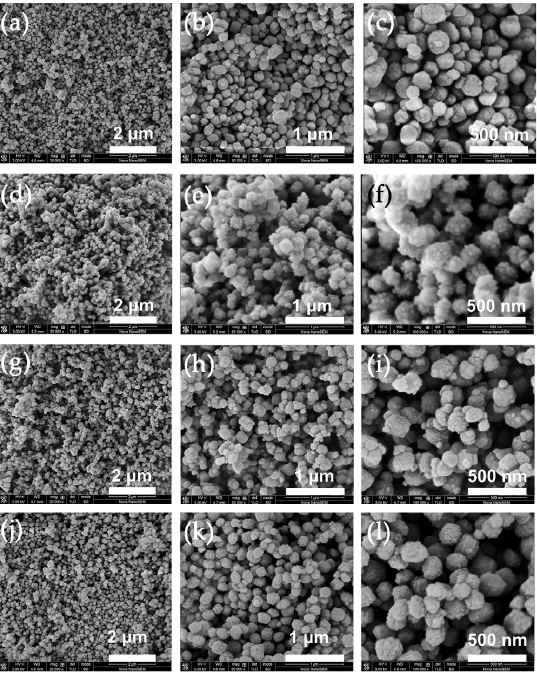
Figure 2. FE ‐ SEM micrographs of ZSM ‐ 5 with Si/Al ratio of 100 synthesized with different amounts of toluene: ( a – c ): 0; ( d – f ): 200; ( g – i ): 400; ( j – l ): 600.